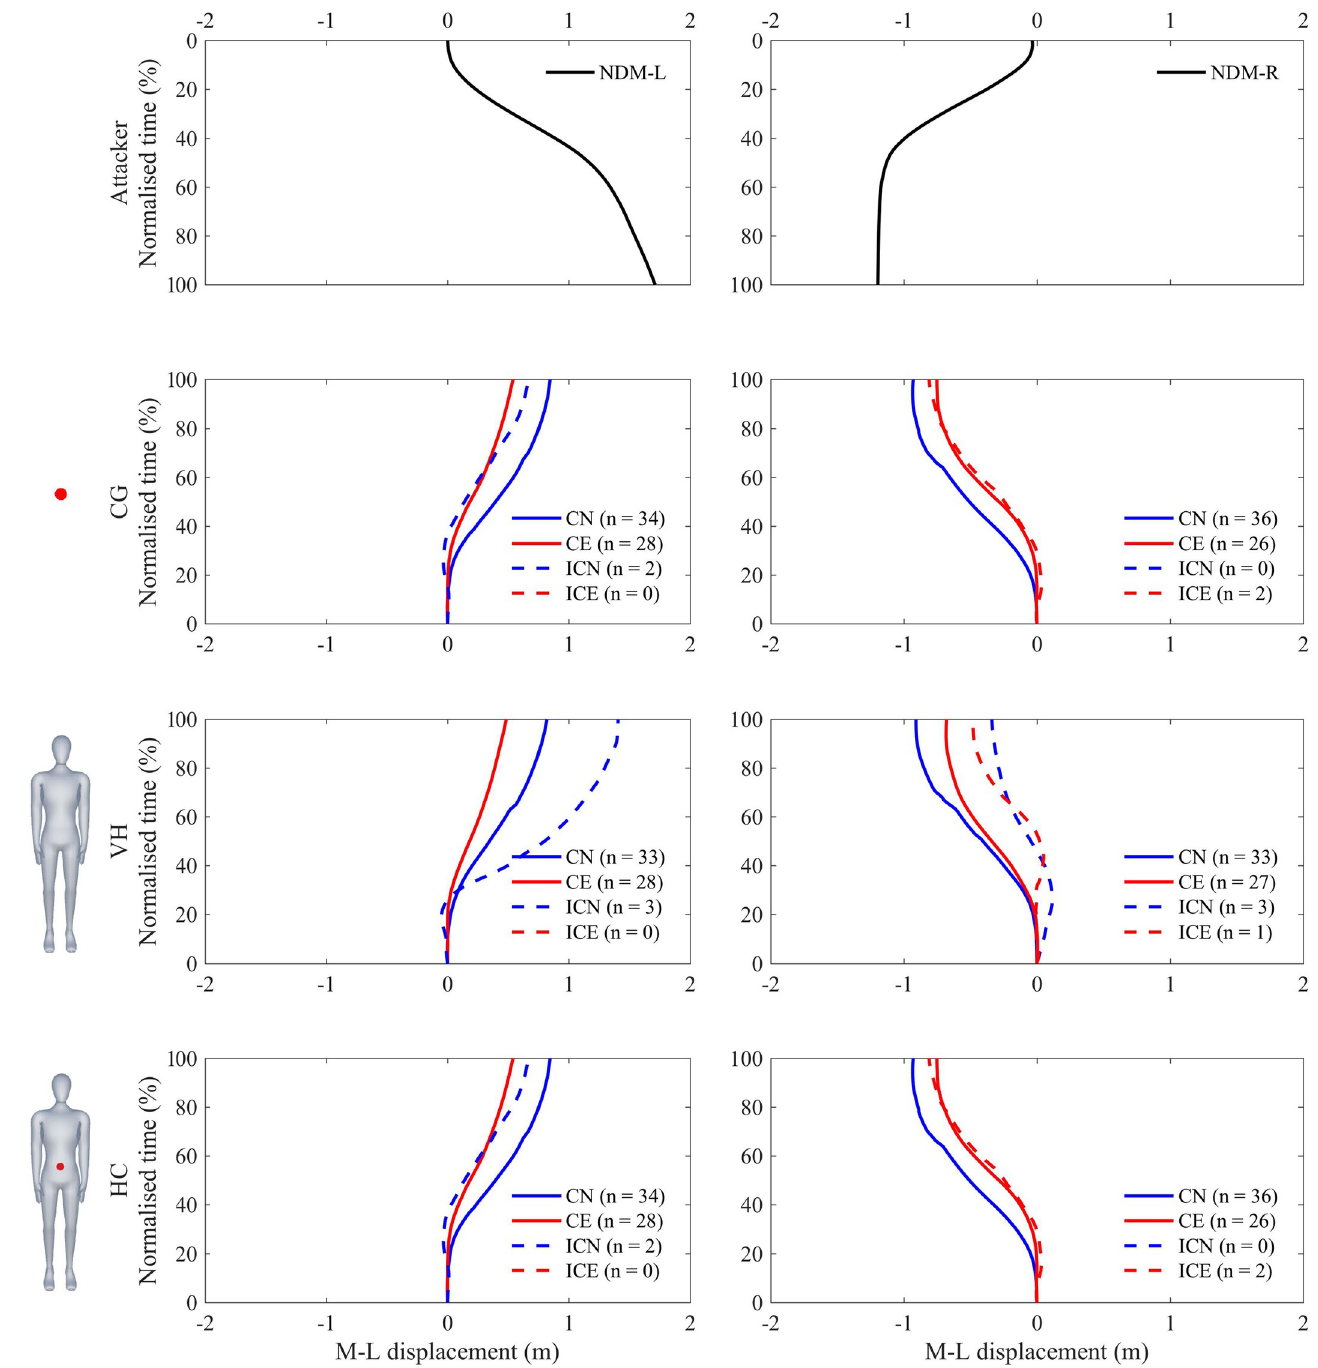
Fig 7. Average medio-lateral response displacement during non-deceptive motion. Average medio-lateral displacement during normalized time of expert (red) and novice (blue) defenders in successfully (solid line) and unsuccessfully (dashed line) detecting final crossing crossing direction of the attackers motion (top). Columns (left—right) represent the motion of the attacker; NDM-L and NDM-R, and Rows (top—bottom) represent the visual appearance of the attacker; CG, VH, and HC.